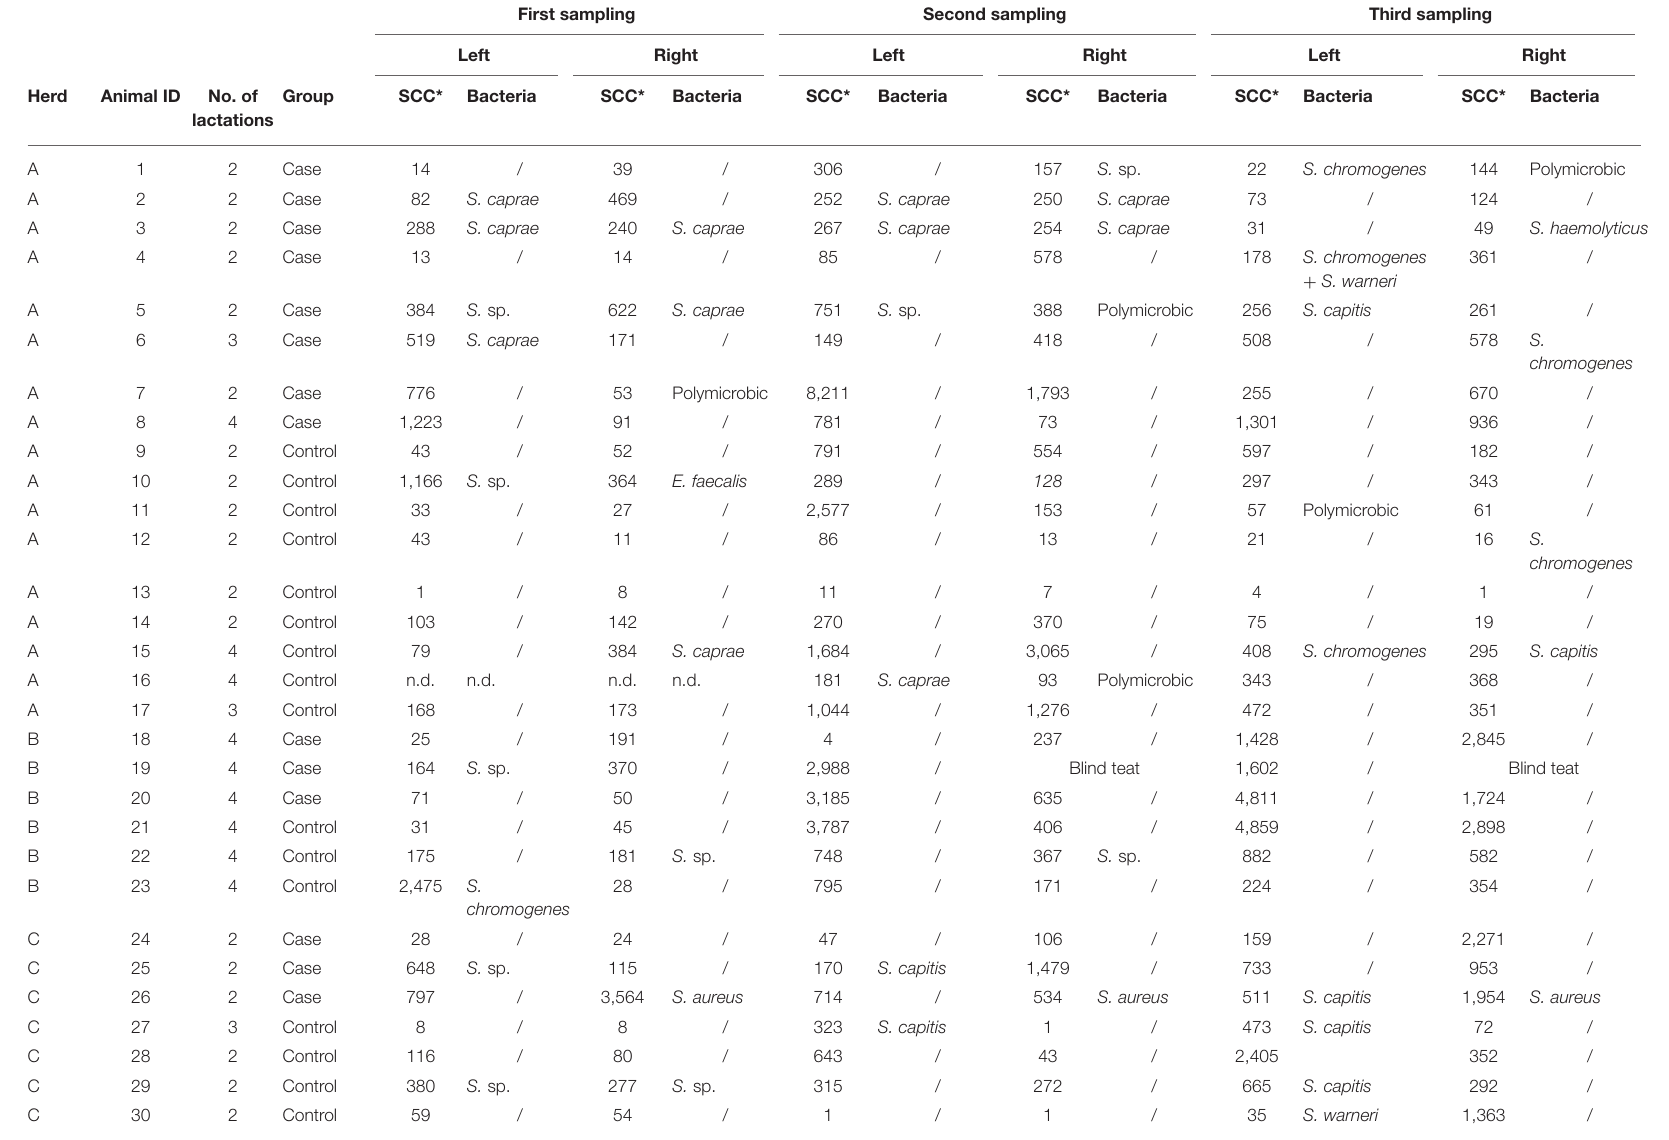
TABLE 1 | Results of bacteriological analysis and SCC determination on half-udder milk samples from 49 Alpine goats (23 cases and 26 controls) collected in 2018 at three timepoints (at the beginning, in the middle and at the end of